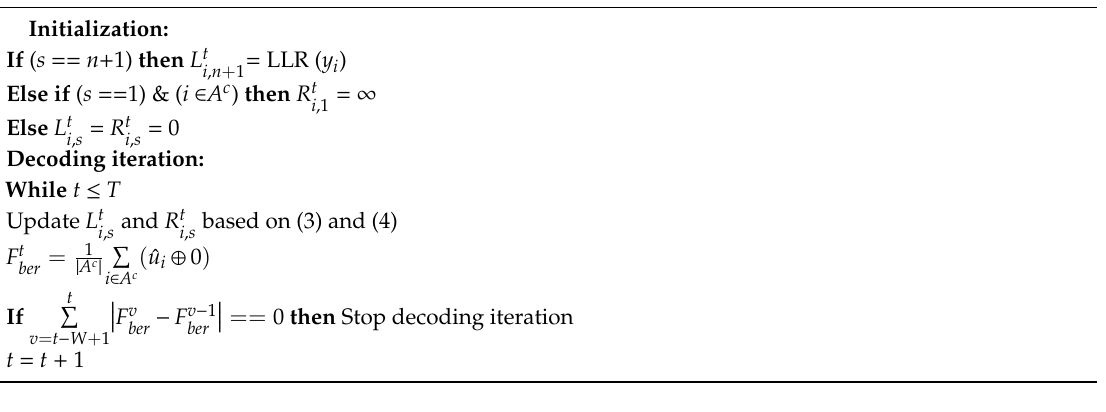
Algorithm 3: Frozen-BER-based [17] early-termination technique